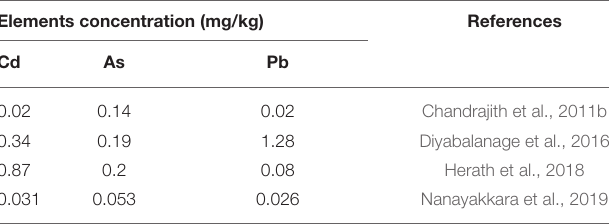
TABLE 2 | Heavy metal(loid)s levels reported in other studies for rice grains of CKDu. Elements concentration (mg/kg)